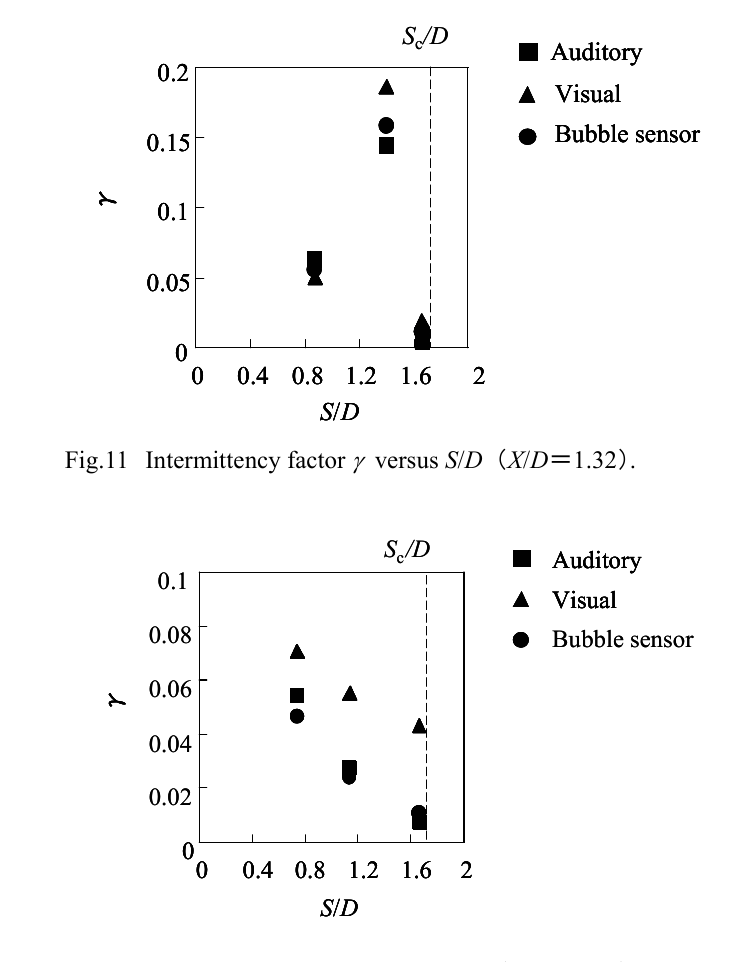
Fig.12 Intermittency factor γ versus S / D （ X / D ＝ 2.32 ）